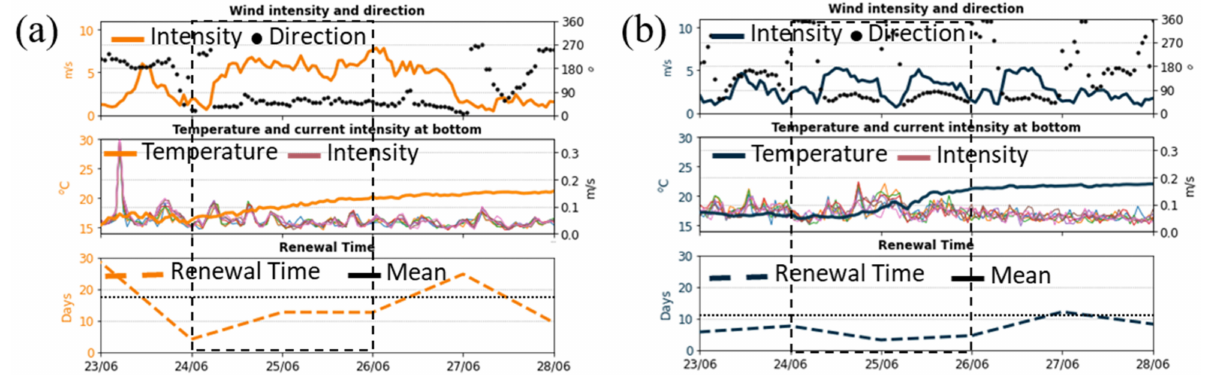
Figure 8. Detailed evolution of wind driving and harbour water responses during the first episode of an abrupt temperature increase in the Barcelona ( a ) and Tarragona ( b ) harbours. Top row: wind intensity (solid line) and wind direction (black dots). Middle row: temperature (thick line) and current speed near the seabed (the thin coloured lines represent the intensity in the deeper layers). Bottom row: turnover times (the black line is the average turnover time of the harbour). The dashed black squares correspond to the day of